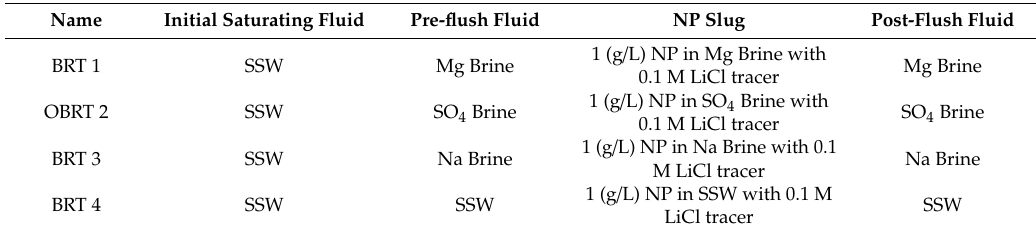
Table 2. Flooding